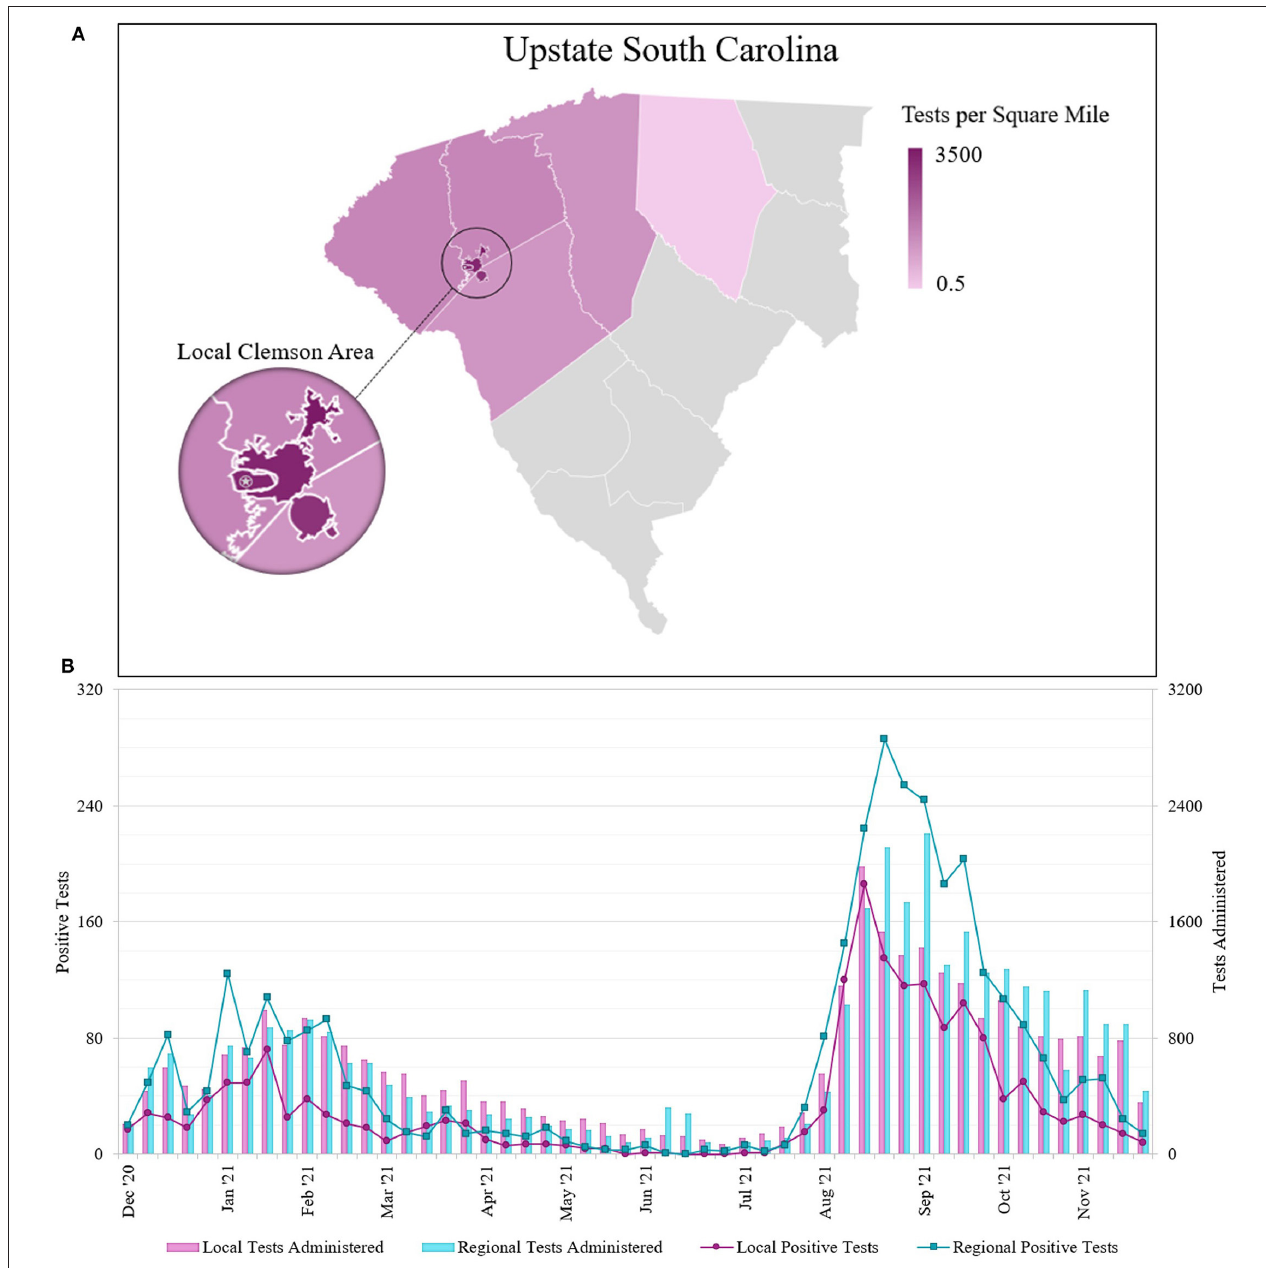
FIGURE 3 | (A) Geographical distribution of SARS-CoV-2 molecular tests performed at the REDDI Lab from December 1, 2020–November 30, 2021 across Upstate SC. Nearly half of all REDDI community tests performed in Upstate SC were performed for residents of local towns of Central, Clemson, and Pendleton. The star indicates the REDDI Lab. Data is presented in tests per square mile. Tests in local towns were subtracted from the county totals and local town areas were subtracted from county areas; counties with 500 tests or less were omitted. The municipalities of Clemson and Clemson University were combined for community tests totals. (B) Number of SARS-CoV-2 saliva tests administered and positive results sorted by patient ZIP code. Local area is defined as the three nearest municipalities: Clemson, Central, and Pendleton (ZIP codes 29631, 29632, 29633, 29634, 29630, and 29670). The regional area includes all other municipalities in Upstate South Carolina, including those omitted from 3A. Note that the positive test number and test administered axes are scaled such that the positive test axis is 10% of the test administered